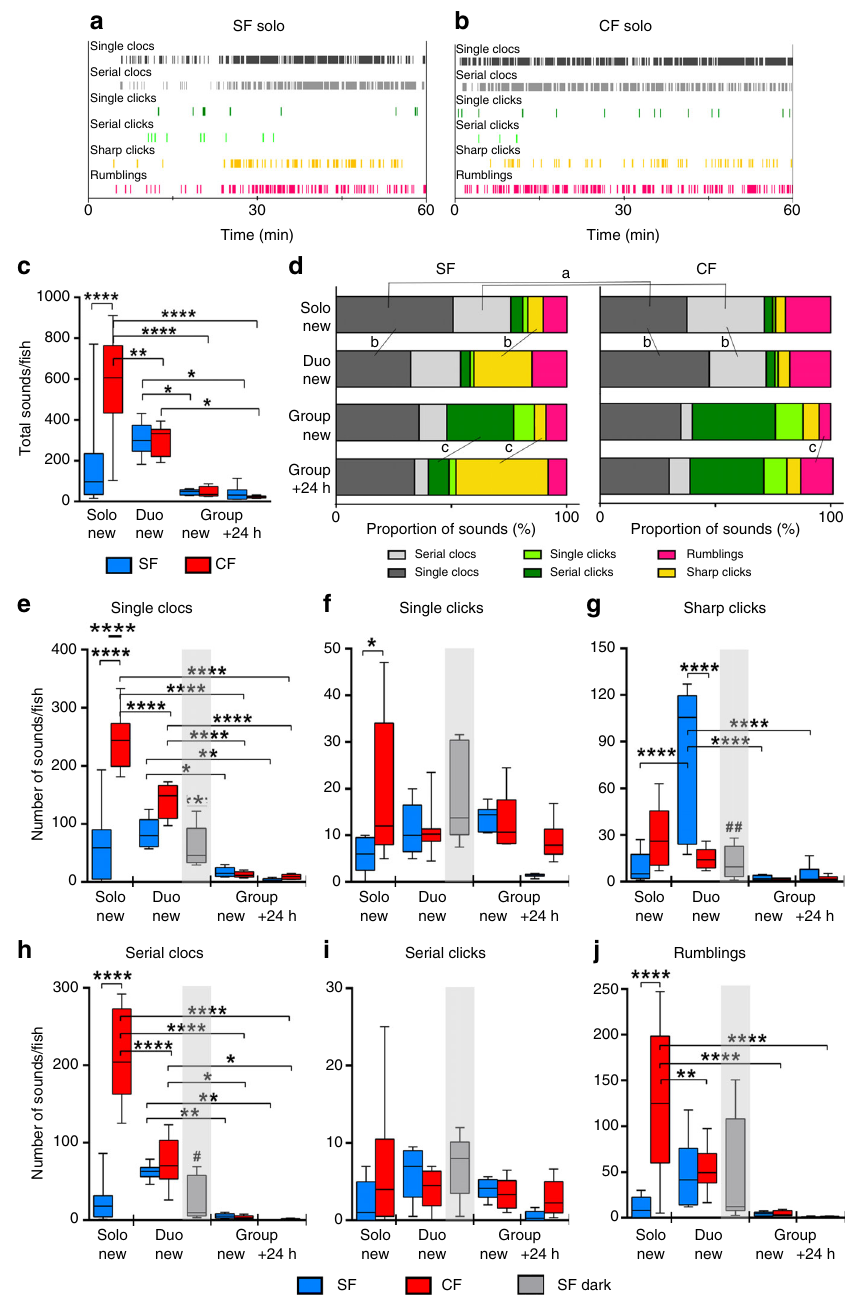
Fig. 3 A. mexicanus sound production depends on contexts and morphotypes. a , b , Representative ethograms for a SF ( a ) and a Pachón CF ( b ) in solo condition, during one hour. Each vertical bar indicates an event and the color code for sounds is indicated. new: new environment; + 24 h: after 24 h habituation. c Total numbers of sounds produced by SF (blue) and CF (red) in solo ( c ) and duo ( d ) context during 30 min (results are normalized per fi sh; 2-way ANOVA (interaction F (3, 52) = 9.1; p < 0.0001). In this and the following fi gures, box plots show the distribution, median and extreme values (top and bottom whiskers) of samples. d Use of the repertoire. The proportions of sounds used by SF or CF, in solo or duo, are indicated in bars. Same color code for sounds as in ethograms. Fisher tests for comparisons: a indicates inter-morph signi fi cance between solo SF and solo CF; b indicates intra-morph signi fi cance between solo and duo context; c indicates intra-morph signi fi cance between new group and habituated group context. e – j Comparison of amounts of sounds produced during 30 min in solo, duo or group condition, in SF and Pachón CF, for the 6 sound categories (results are normalized per fi sh; 2-way ANOVA interactions: F = 20.2; p < 0 = 3.8; p = 0.03 ( f ), F = 17.7; p < 0.0001 ( g ), F = 41.6; p < 0.0001 ( h ), F (2, 38) . 0001 ( e ), F (2, 38) (2, 38) (2, 38) (2, = 1.6; p = 0.2 ( i ), F = 9.3; p = 0.0005 ( j )). On each graph, the sound type, the morph (SF in blue, Pachón CF in red), and the context are indicated. 38) (2, 38) Gray bars correspond to SF duos in the dark. Bonferroni posthoc : **** p < 0.0001, ** p < 0.01, * p < 0.05. Duo SF in the light and in the dark were compared separately with Mann – Whitney tests: U = 3; p = 0.005 ( g ), U = 7; p = 0.03 ( h ), # p > 0.05, ## p < 0.01. Data are means ± SEM. See also Supplementary Data 3 for exhaustive statistics. Source data are provided as a Source Data fi le